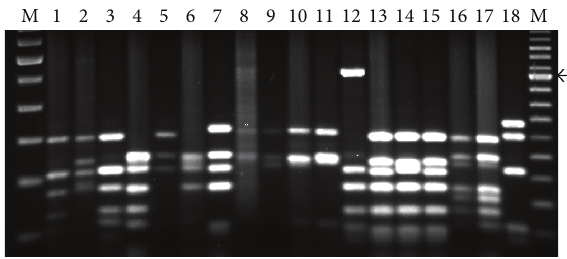
Figure 1: PCR-RFLP patterns in some wild relatives of brassicas obtained in the combination DT- Taq I. Lanes 1–18 are Dvi1, Das1, Dca1, Deru1, Bto1, Bcr2, Bcr1, Bel1, Bel2, Bel3, Bel4, Bgr1, Bma1, Bma2, Bma3, Bba1, Bba2, and Bso1, respectively. Intraspecific varia- tions shown in B. cretica (lanes 6 and 7), B. elongata (lanes 8 to 11), and B. maurorum (lanes 13 to 15). See Table 1 for code of species and accessions.M:100 bpladder(left)and50 bpladder(right)molecular size markers; arrow indicates 500 bp